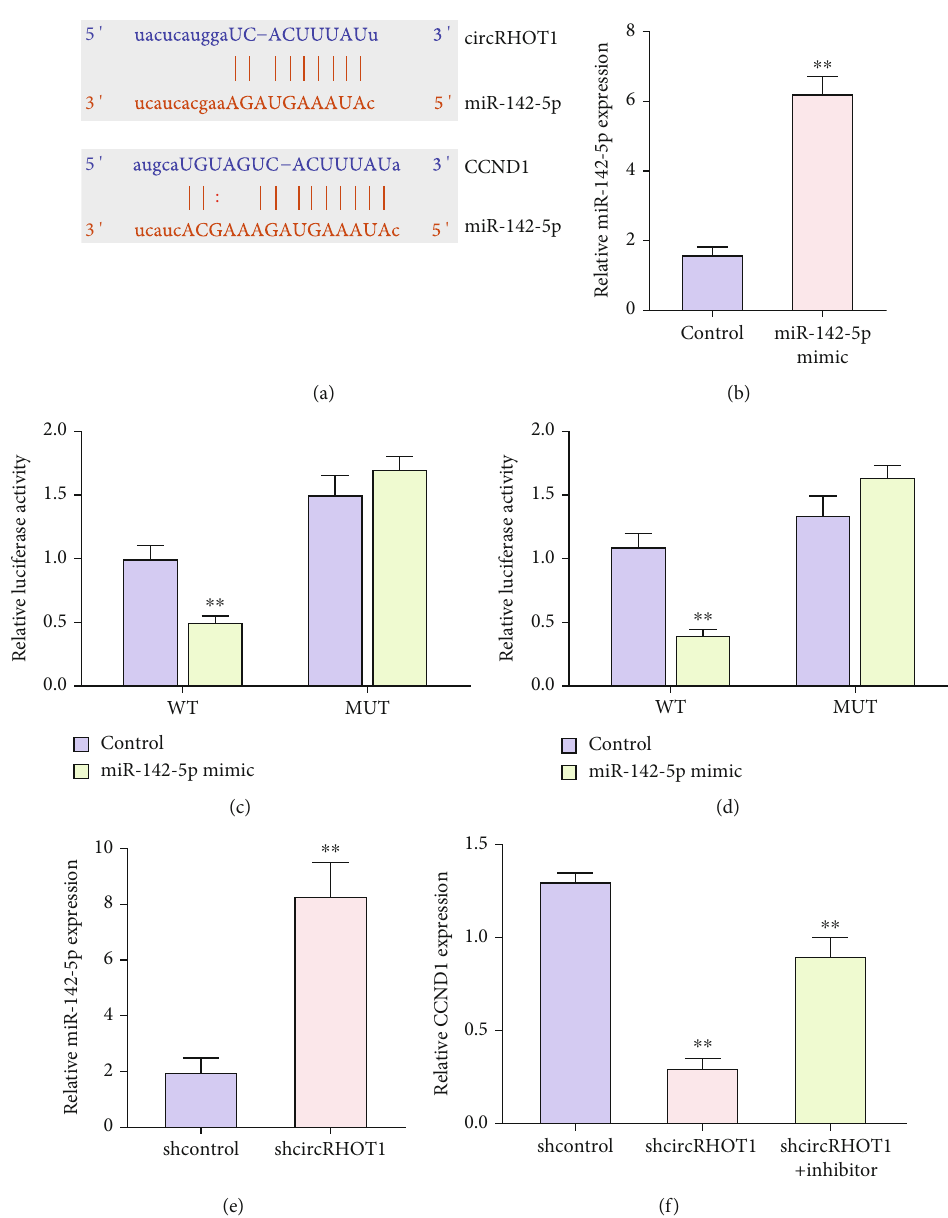
Figure 5: CircRHOT1 is able to enhance the CCND1 expression by sponging miR-142-5p in chondrocytes. (a) The potential interaction of miR-142-5p with circRHOT1 and CCND1 was predicted. (b) – (d) The chondrocytes were treated with miR-142-5p mimic. (b) The expression of miR-142-5p was measured by qPCR. (c) The luciferase activity of circRHOT1 was determined by luciferase reporter gene assay. (d) The luciferase activity of CCND1 3 ′ UTR was analyzed by luciferase reporter gene assay. (e) The expression of miR-142-5p was tested by qPCR in chondrocytes treated with circRHOT1 shRNA. (f) The expression of CCND1 was detected by qPCR in chondrocytes treated with circRHOT1 shRNA and miR-142-5p inhibitor. Mean ± SD , ∗∗ P < 0 : 01